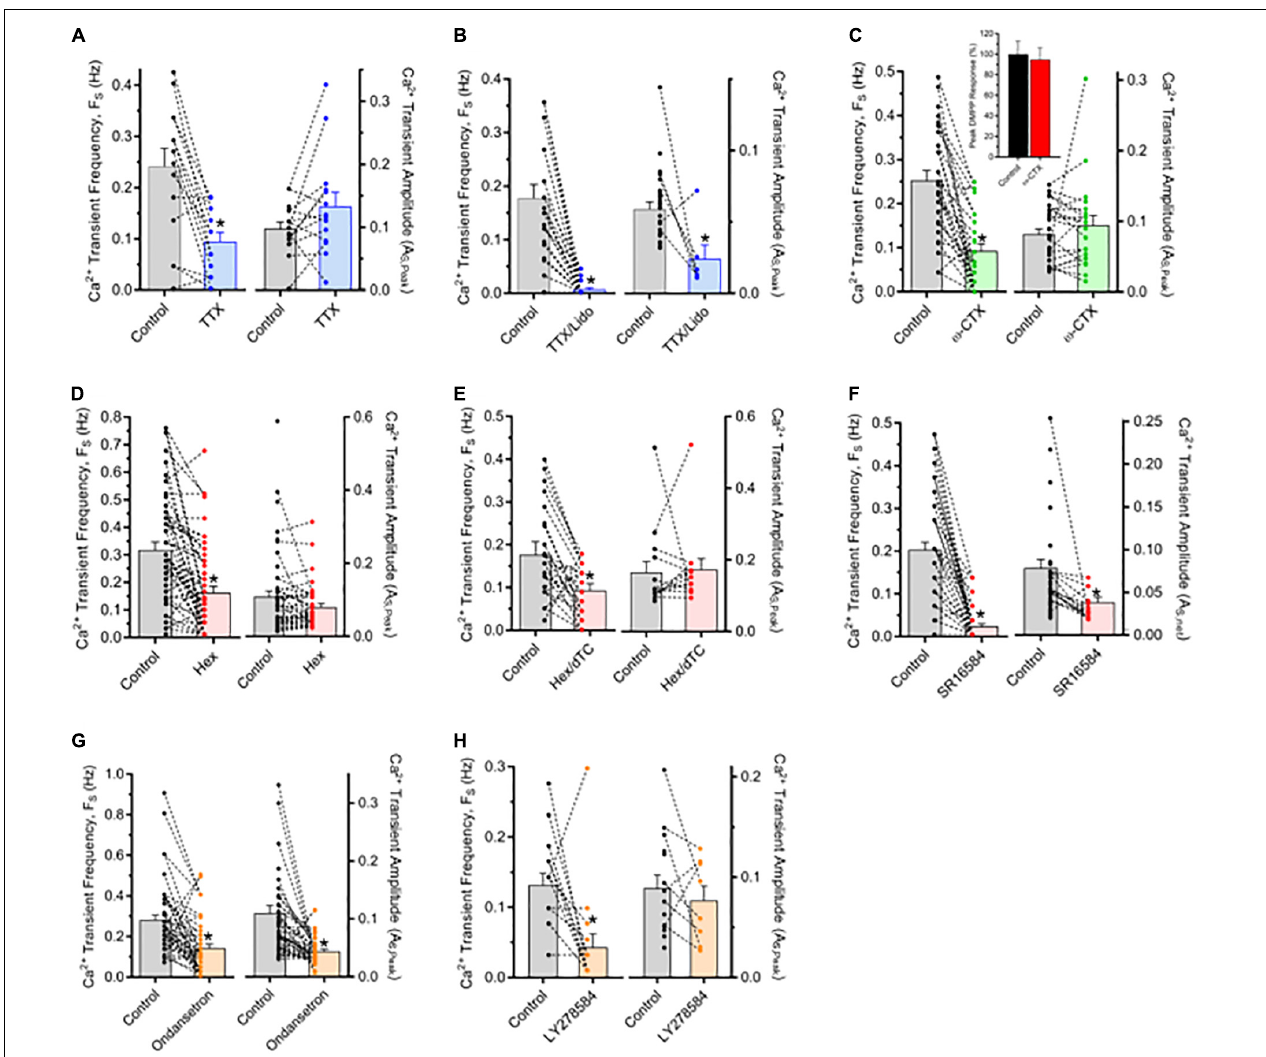
FIGURE 3 | Spontaneous Ca 2 + transients depend on impulse-driven synaptic transmission mediated by nAChRs and 5-HT 3 Rs. The results depict F S and A S , Peak measurements from neuron pairs in ChAT + /GCaMP6f + MG explants tested before (Control) and after treatment with antagonists (as indicated). Bar graphs depict F S (left) and A S , Peak (right) averages while the superimposed dot plots and connecting lines depict their values from individual neurons before and after treatment. In the legend and text changes in F S and A S , Peak are presented as a per cent difference between values for test and control group neurons within a field. Note that A S , Peak is represented for neurons from only those records where F S > 0. (A, B) Ca 2 + transients depend on impulses requiring voltage-gated Na + channels. (A) Tetrodotoxin (TTX; 1 µ M, 15 min) reduced F S by 61 ± 7% ( n = 15; N = 1) without affecting A S , Peak . (B) Combining TTX with 2 mM Lidocaine (TTX/Lido, 15 min) to also block TTX-resistant Na + channels nearly abolished the Ca 2 + transients resulting in a 96 ± 2% reduction in F S ( n = 27; N = 2) that was accompanied by a 60 ± 18% reduction in A S , Peak of the few remaining Ca 2 + transients. (C) Ca 2 + transients depend on presynaptic voltage-gated Ca 2 + channel activity necessary for neurotransmitter release. Treatment with ω -CTx (0.1–0.2 µ M; 1 h) reduced F S by 62 ± 7% ( n = 30; N = 2) without affecting A S , Peak . In a separate explant, the response of 15 neurons to DMPP (10 µ M) applied as in Figure 1 was unaffected by ω -CTx treatment (inset). (D–F) Most Ca 2 + transients depend on nAChR activation. (D) Hex (100–200 µ M, 15 min) reduced F S by 42 ± 9% ( n = 52; N = 3) without affecting A S , Peak . (E) Combining 100 µ M mHex with 100 µ M dTC (Hex/dTC, 15 min) had nearly identical effects, reducing F S by 51 ± 13% ( n = 29; N = 1) without affecting A S , Peak . (F) Treatment with SR16584 (40 µ M, 15 min) to selectively target α 3 β 4*-nAChRs, potently inhibited the MG neuron Ca 2 + transients reducing F S to zero in 35 of 50 neurons (85 ± 5% reduction overall; n = 50, N = 3) and having no effect on residual A S , Peak in 7 of 15 neurons while reducing A S , Peak in the remaining 8 neurons by 64%. (G,H) Most Ca 2 + transients also depend on 5-HT 3 R activation. Ondansetron (20 µ M; 10–20 min) reduced F S by 70 ± 10% and A S , Peak by 54 ± 4% ( n = 51; N = 4) while in one experiment LY278584 (10 µ M; 20 min) reduced F S by 67 ± 15% while nominally reducing A S , Peak by 14 ± 25% ( n = 15).